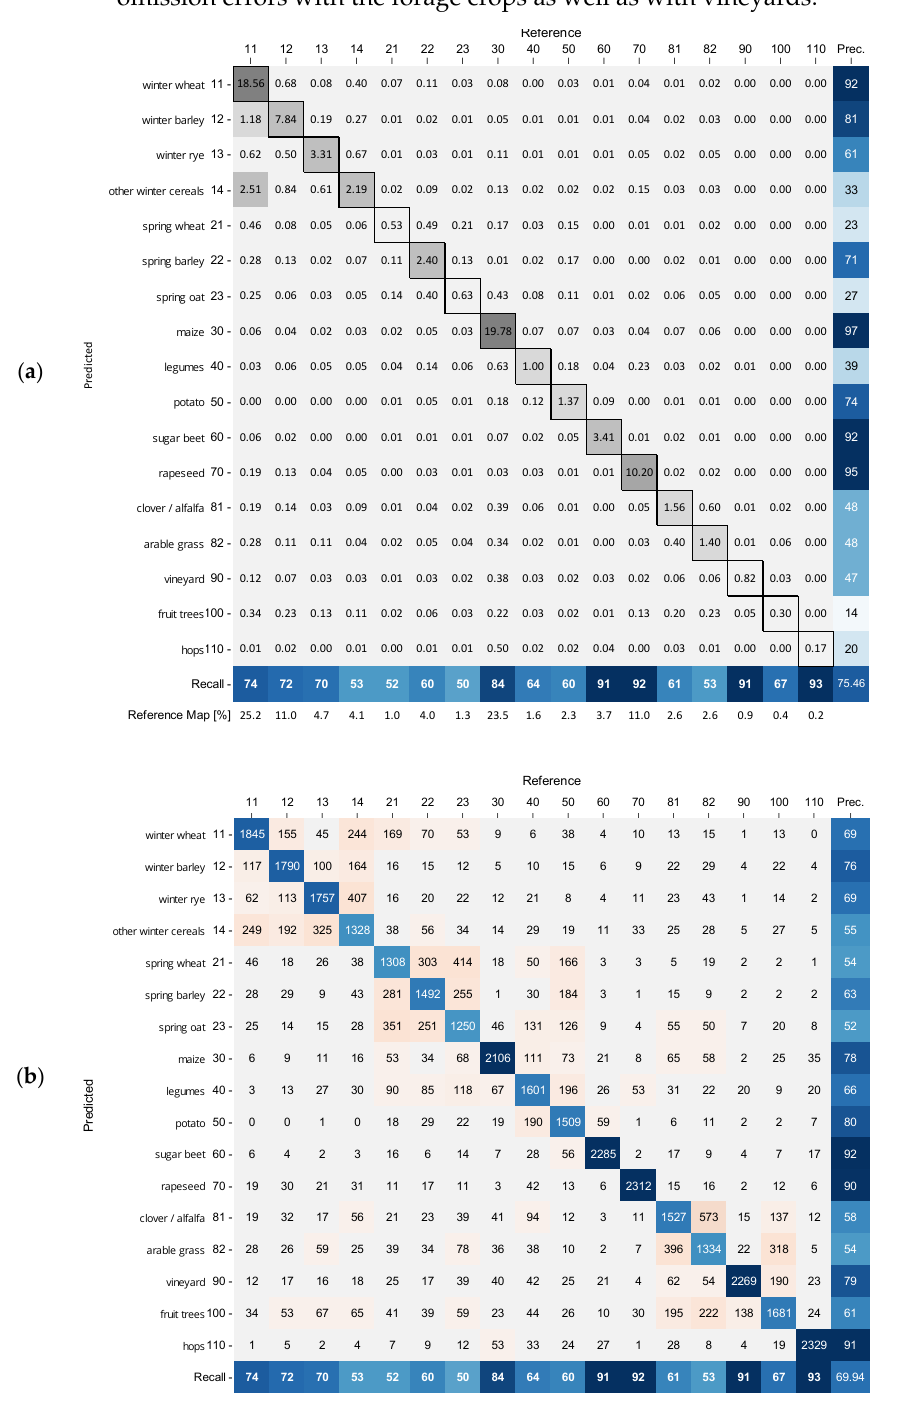
Figure 5. Confusion matrices for the “S12” crop type classification for Germany 2018 based on ( a ) area proportion and ( b ) sample